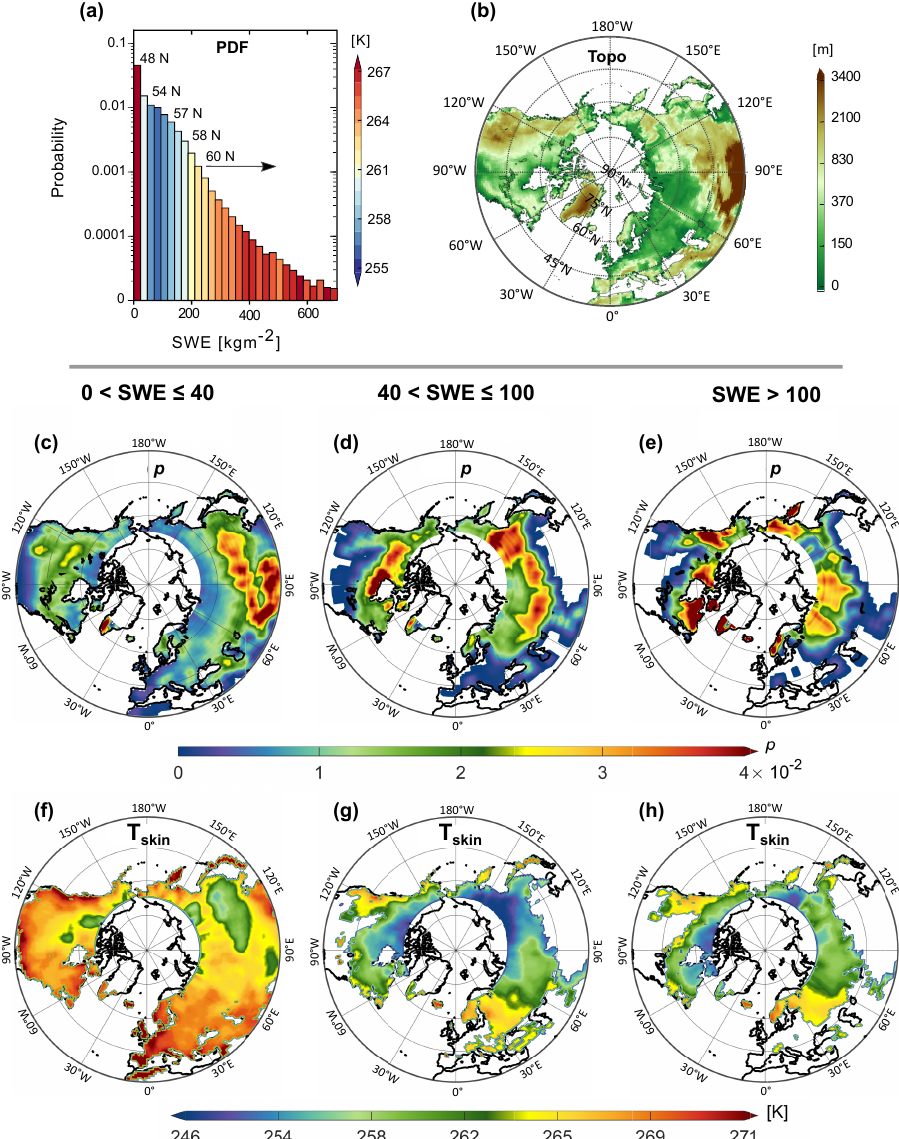
Figure 1. Marginal probability distribution function (PDF) of multi-year Snow Water Equivalent (SWE in kgm − 2 ) and T skin (in degree K) dependency ( a ), NH topographic map ( b ), SWE spatial probability of occurrence ( p ) ( c – e ), and T skin ( f – h ) at 1 deg resolution for three SWE intervals in kgm − 2 . Note the color scale in ( a , b ) indicates the average T skin (K) for each SWE bin and the elevation (m), respectively. Note that the y-axis in ( a ) is